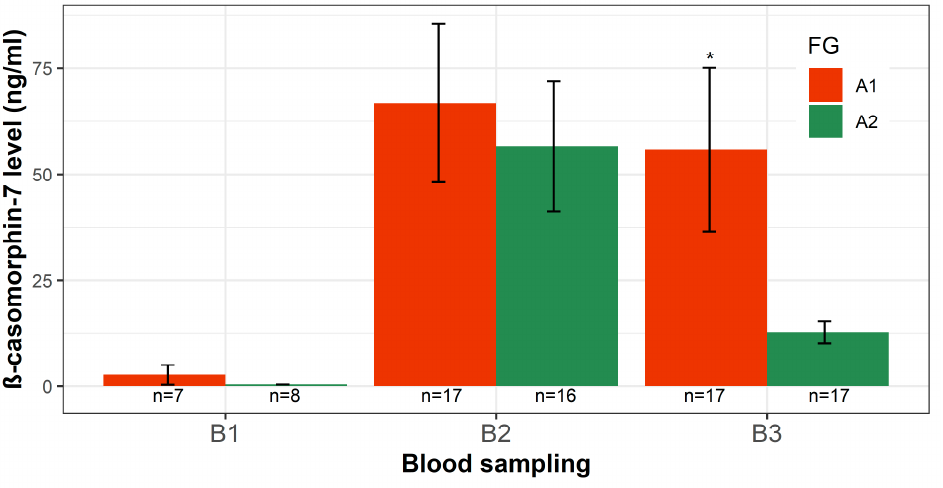
Figure 6. β -casomorphin-7 level in plasma of calves per feeding group (FG) at a different time of blood sampling. B1 = day 0; B2 = day 3; B3 = day 21. * p < 0.05, refers to t -test comparison between both feeding groups for each blood sampling. Black bars indicate standard errors.